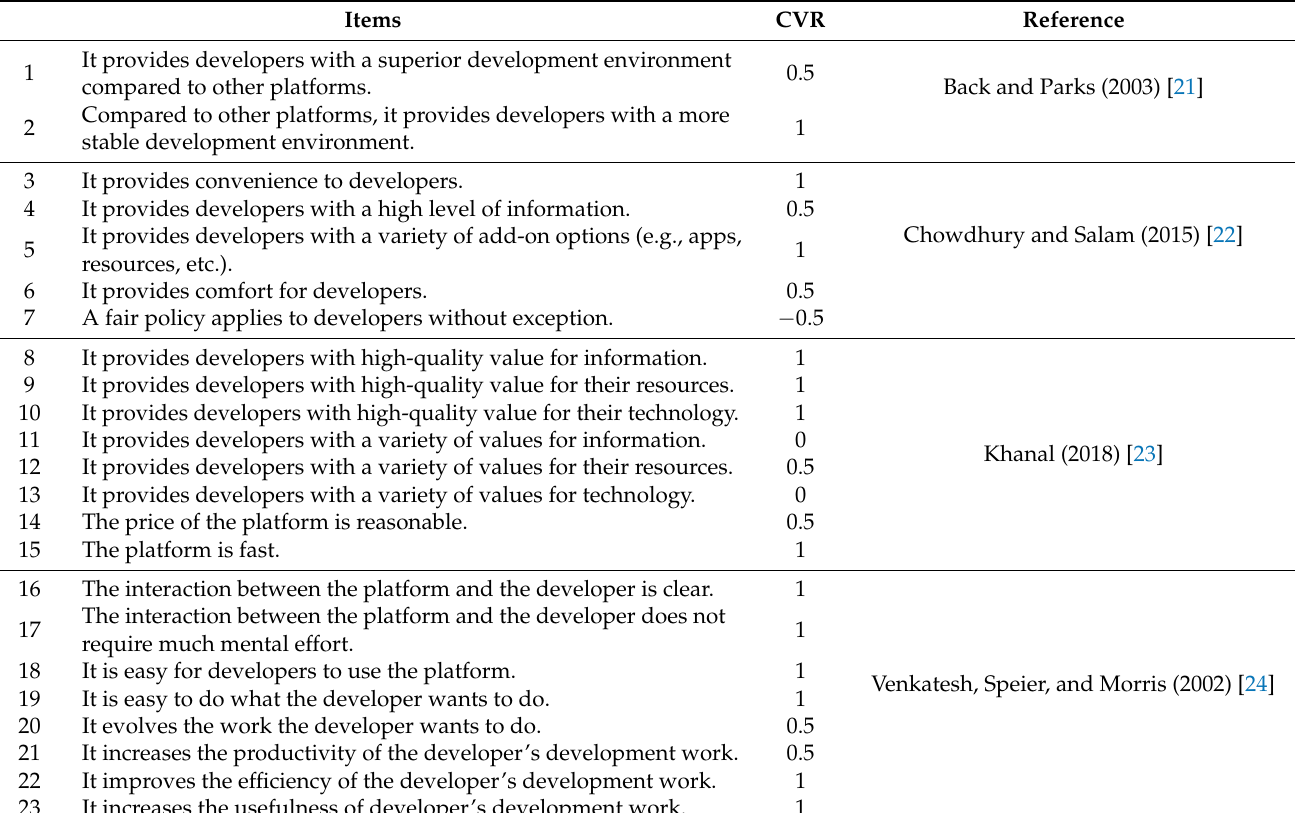
Table 1. Pilot items for the measurement of cognitive factor and calculated CVRs.